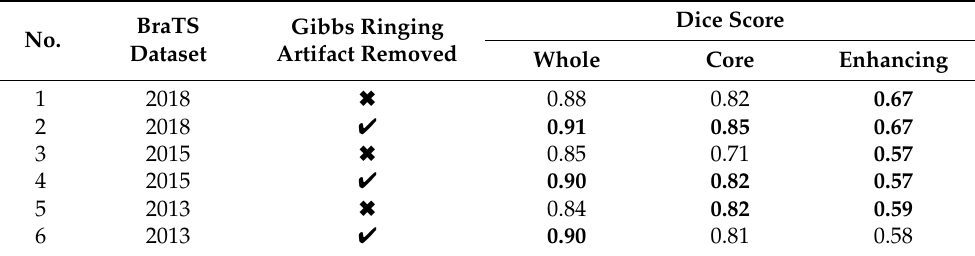
Table 1. Comparison of brain MRI images with ( (cid:54) ) Gibbs ringing artifact and without ( (cid:52) ) Gibbs ringing artifact using local sub voxel-shift method.